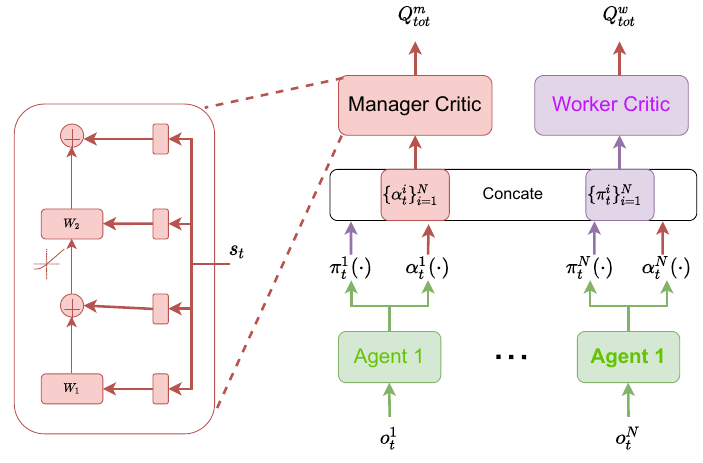
Figure 3. The structure of the MLCA